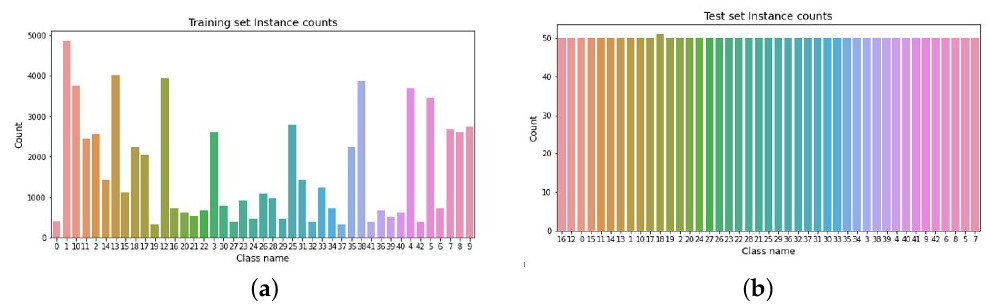
Figure 4. Instances count for the traffic sign dataset. ( a ) Training instance count for the traffic sign dataset. ( b ) Test instance count for the traffic sign dataset.